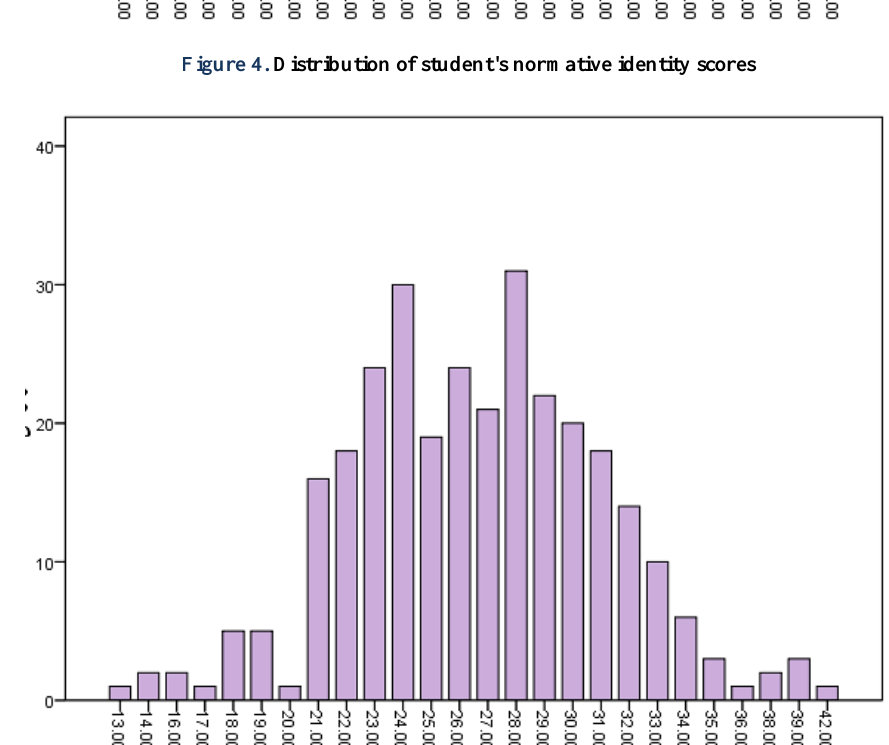
Figure 5. Distribution of student's diffuse identity